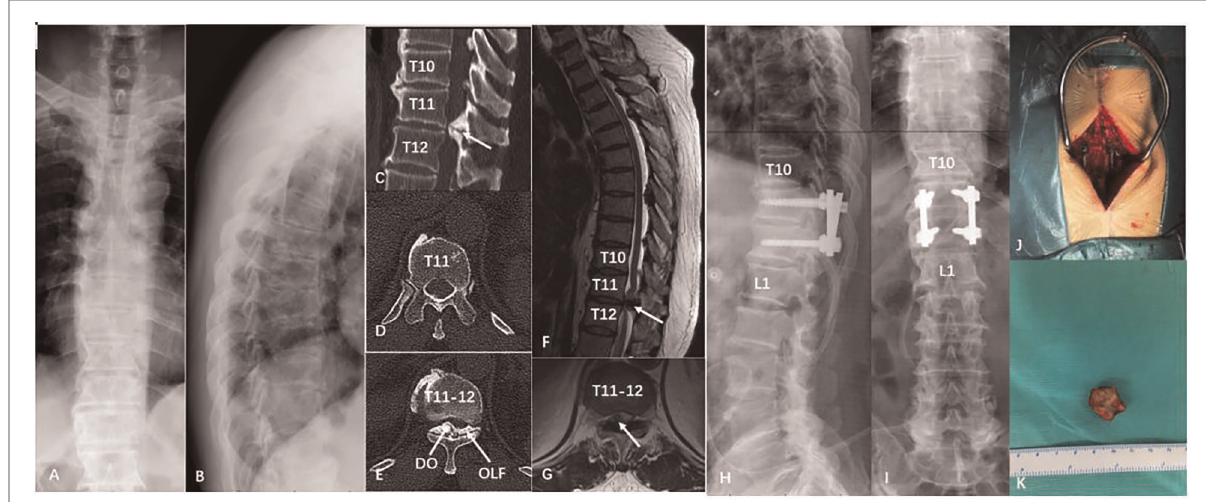
FIGURE 1 A patient with thoracic ossi fi cation of ligamentum fl avum in T11/12. ( A,B ) Preoperative x-ray; ( C-E ) Preoperative coronal and axial section computed tomography scan; ( F,G ) Preoperative sagittal and axial section magnetic resonance imaging scan; ( H,I ) Postoperative x-ray; ( J,K ) Intraoperative photo and postoperative sample of ligamentum fl avum ossi fi